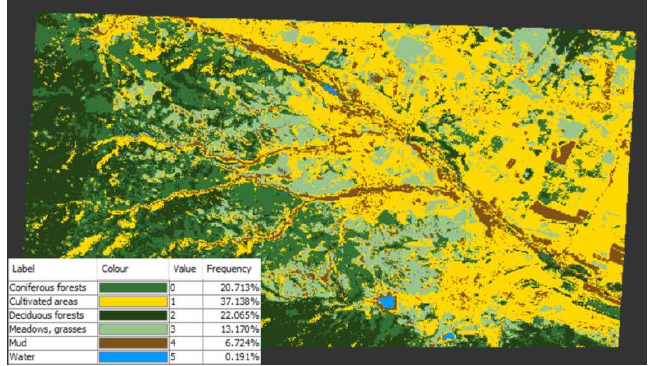
Figure 12. Maximum likelihood classifier